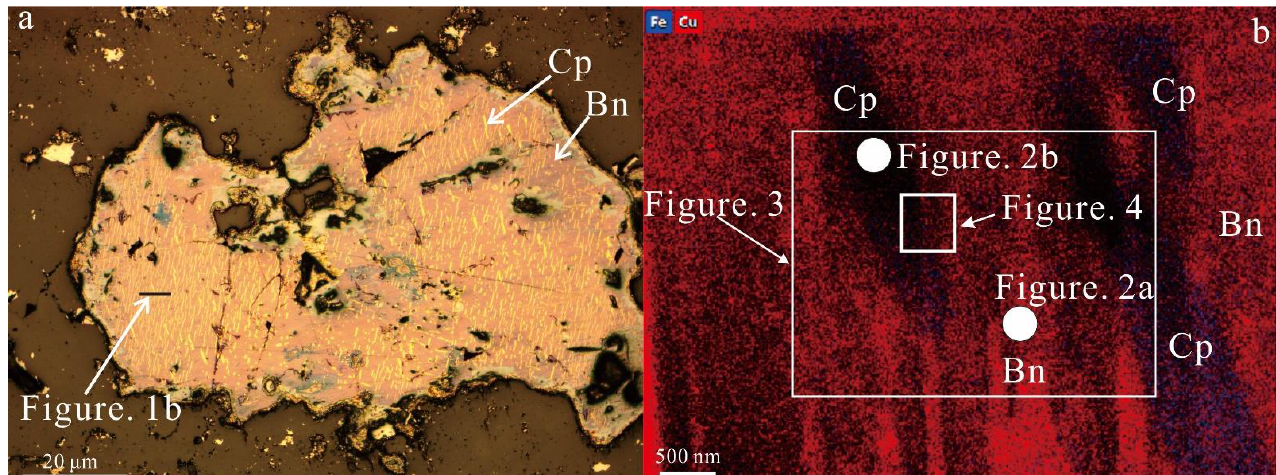
Figure 1. ( a ) Exsolution texture of Cu-(Fe)-sulfides from the 109 Cu deposit, showing the submicron yellow lamellar sets of chalcopyrite exsolution in the “amaranth” bornite. The black label is the location for FIB; ( b ) EDS mapping for FIB cross-section imaging of bornite–chalcopyrite intergrowths, showing that a set of sub-micrometer-sized lamellae of chalcopyrite in bornite are parallel with one another. Cp: chalcopyrite, Bn: bornite. The white square is the location of HR-TEM of the bornite – chalcopyrite intergrowths. The white circles are the locations of EDS spot analysis.